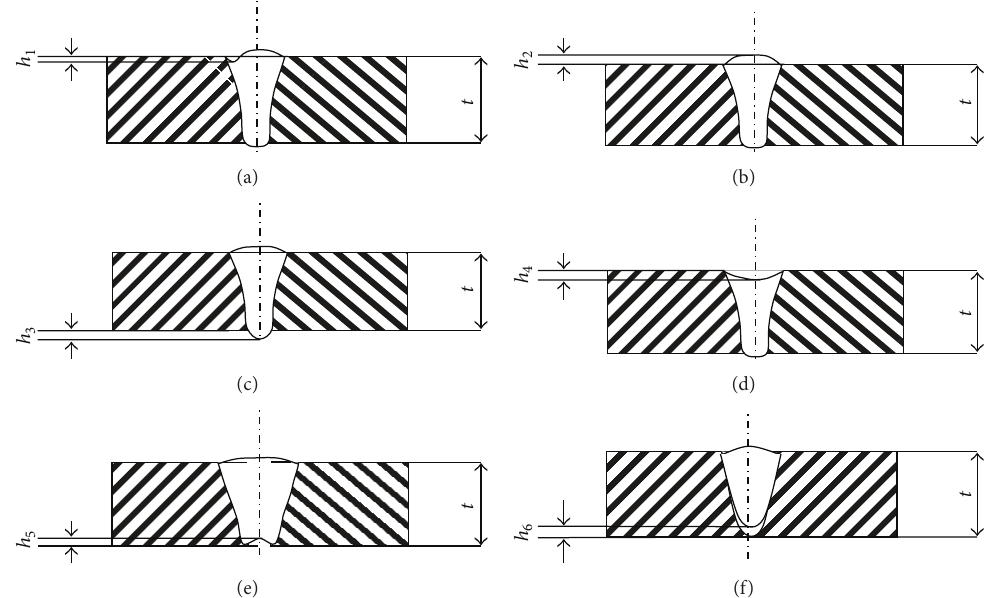
Figure 2: Geometrical imperfection considered for the analysis: (a) weld undercut ℎ 1 , (b) excess weld metal ℎ 2 , (c) excessive penetration ℎ 3 , (d) incomplete fill groove ℎ 4 , (e) root concavity ℎ 5 , and (f) lack of penetration ℎ 6 .